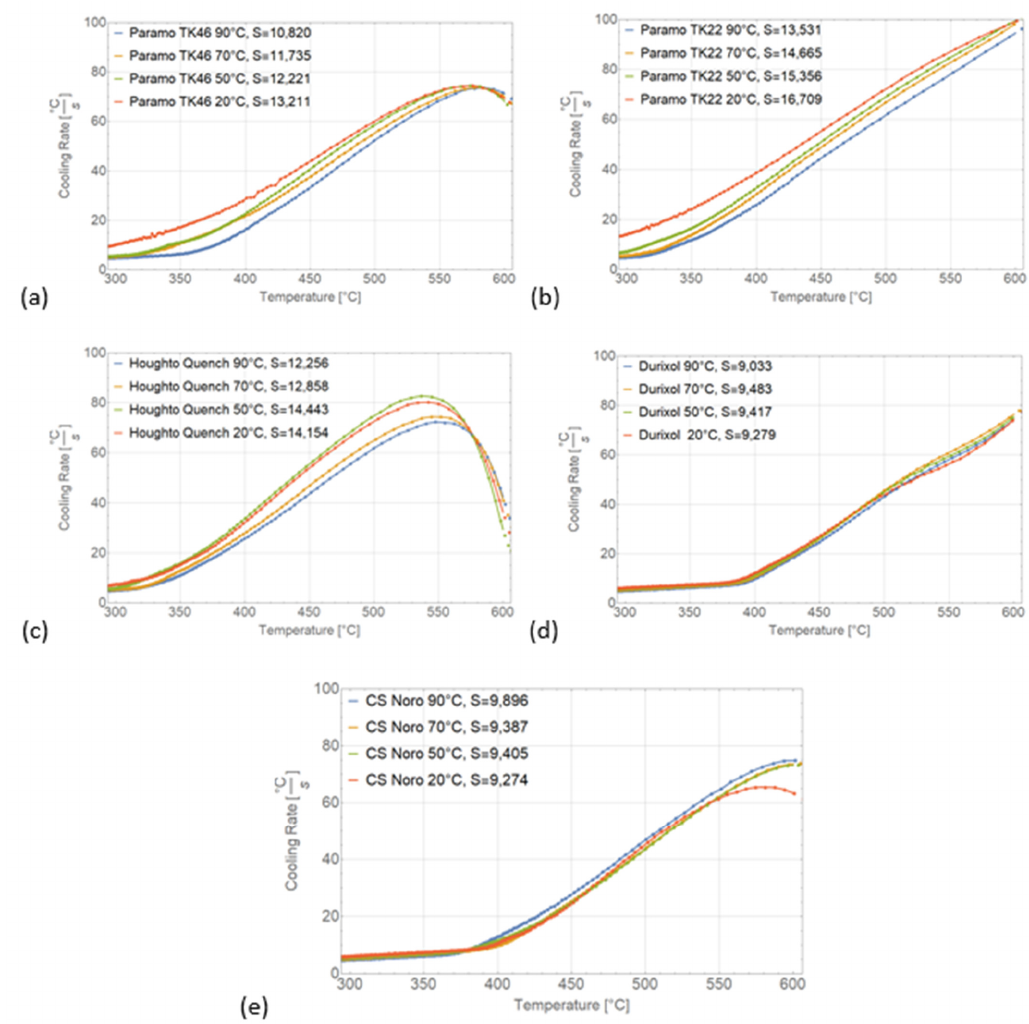
Figure 6. Results of integration yield the areas under the curve for cooling between 300–600 °C at the quenchant temperatures of 20 °C, 50° C, 70 °C and 90 °C. ( a ) Paramo TK46, ( b ) Paramo TK 22, ( c ) Houghto Quench, ( d ) Durixol, ( e ) CS Noro.